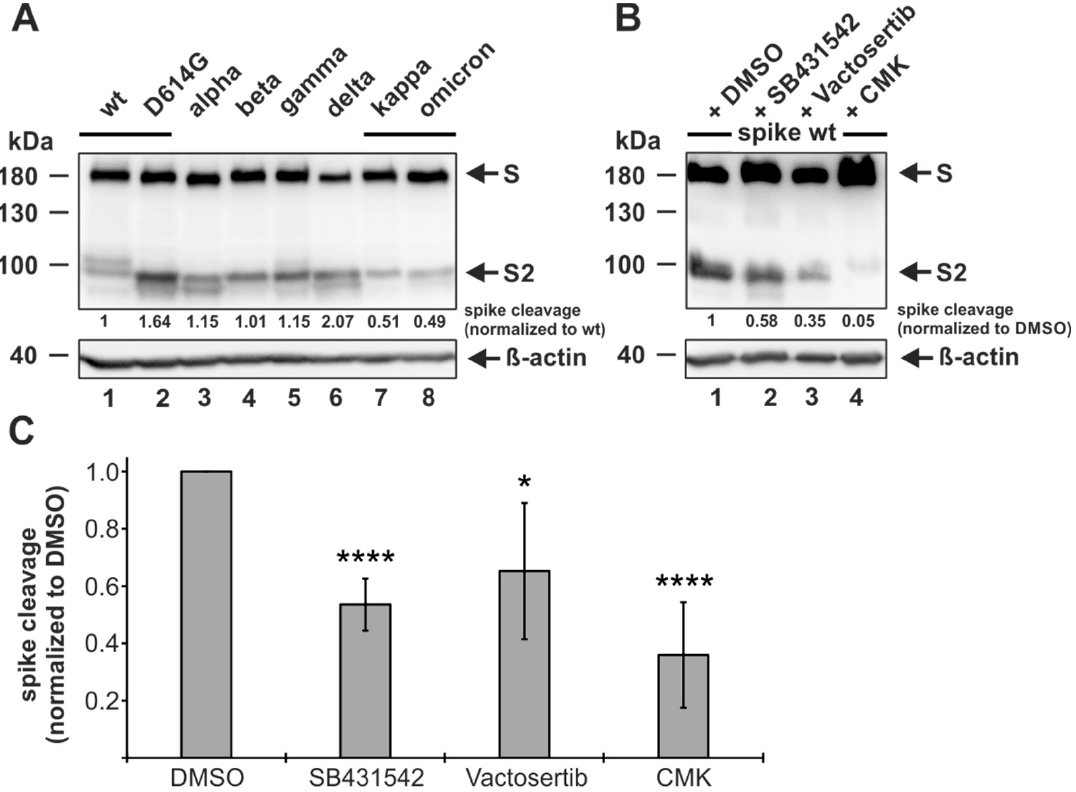
Figure 5. Reduction of proteolytic processing of spike by ALK5 inhibition. ( A ) HEK293T cells were transfected with the indicated constructs, and at 48 h post transfection, were harvested and analyzed by Western blotting for the S2 subunit of spike and ß-actin. Spike cleavage, normalized to the spike wildtype (wt), was determined by quantification of uncleaved spike (S) and cleaved spike (S2) via densitometric analyses utilizing the Image Lab Software. ( B ) HEK293T cells were pre-incubated with 10 µM SB431542, Vactosertib, CMK or the solvent control DMSO. 24 h later, cells were transfected with spike wt, and at 48 h post transfection, were harvested and analyzed by Western blotting for the S2 subunit of spike and ß-actin. Spike cleavage, normalized to DMSO, was determined by quantification of uncleaved spike (S) and cleaved spike (S2) via densitometric analyses utilizing the Image Lab Software. ( C ) Spike cleavage obtained by five independent experiments, conducted as in 5B, is represented by mean values ± SD. The p -values were calculated using two-tailed Student’s t -test. * p ≤ 0.05; **** p ≤ 0.0001.